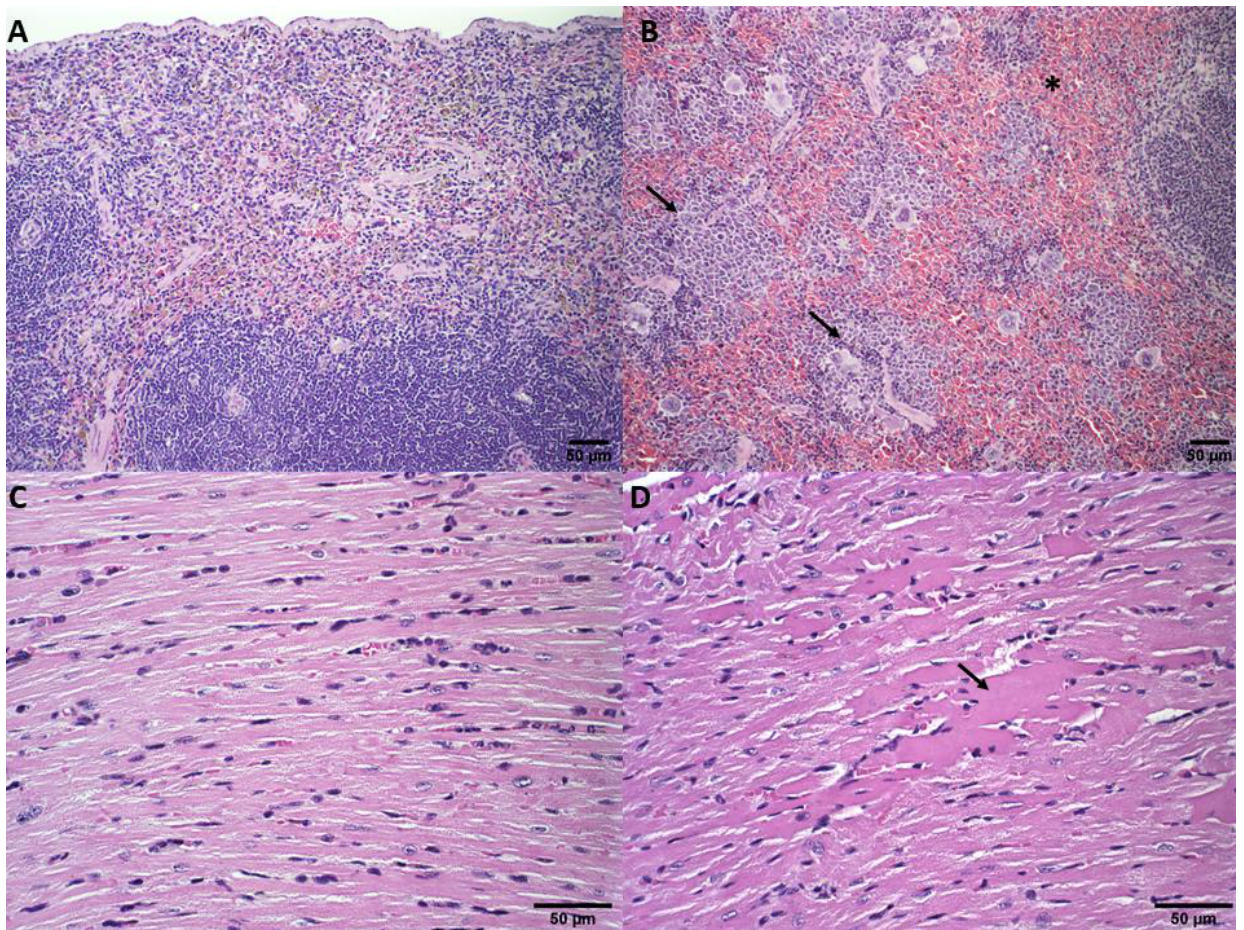
Figure 7. Histological sections of the spleen ( A , B ) and heart ( C , D ) of female Balb/c mice bearing 4T1 breast tumors. ( A ) Represents the groups treated with SpHL-DOX and ExoSpHL-DOX. Normal spleen. ( B ) Represents the groups treated with HBS, ExoSpHL, and DOX. The asterisk indicates red pulp hyperplasia, and arrows indicate the white pulp hyperplasia of the spleen. ( C ) Represents the groups treated with HBS and ExoSpHL. Normal heart. ( D ) Represents the groups treated with DOX, SpHL-DOX, and ExoSpHL-DOX. The arrow indicates the areas of degenerative hyalinization in the heart. HE, scale bar = 50 µm.